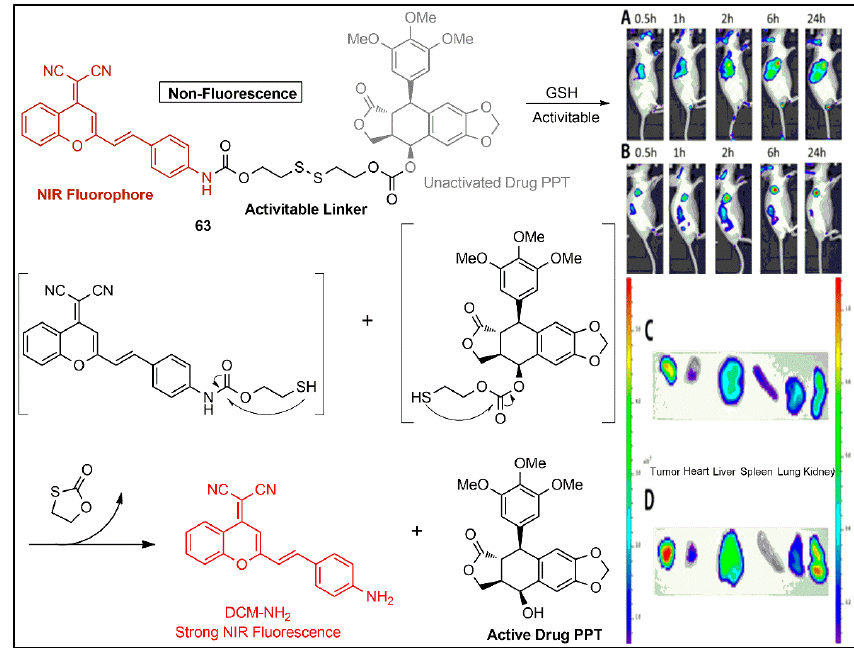
Figure 58. PPT release mechanism of the activatable prodrug by treatment of GSH. In vivo imaging of nude mice bearing tumor after intravenous injection of (A) 63 (1 mg/kg PPT) and (B) mPEG-DSPE/ 63 (1 mg/kg PPT) at various time points (0.5, 1, 2, 6, and 24 h). Ex vivo fluorescence images of the different organs of mice, including kidney, lung, spleen, liver, heart, and tumor, which were sacrificed at 24 h post-injection with (C) 63 and (D) mPEG-DSPE/ 63 . Adapted with permission from [167]. Copyright (2017) American Chemical Society.